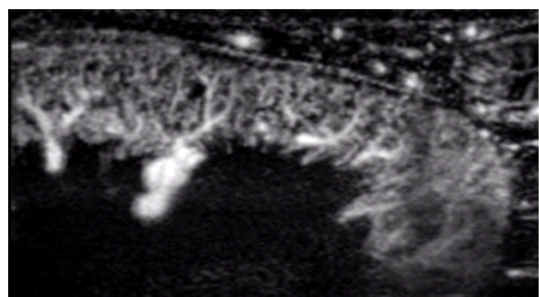
Figure 2 Harmonic contrast enhanced ultrasound of the kidney by MicroFlow Imaging (Canon Medical Systems, Tustin, CA) demonstrates the renal cortical vasculature.